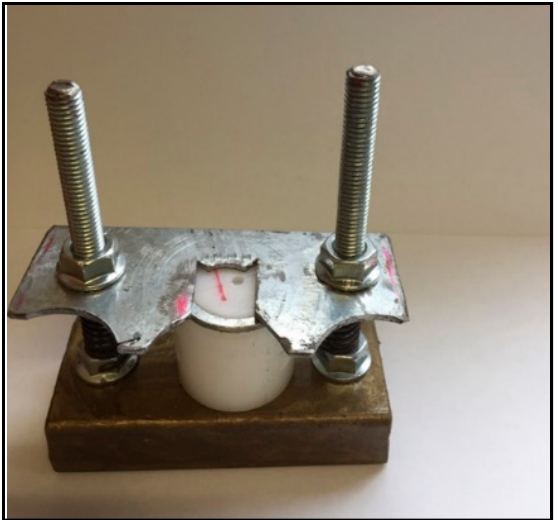
Figure 4. Teflon mold fixed by a metallic device with screws on the tooth surface for bond strength specimen preparation.